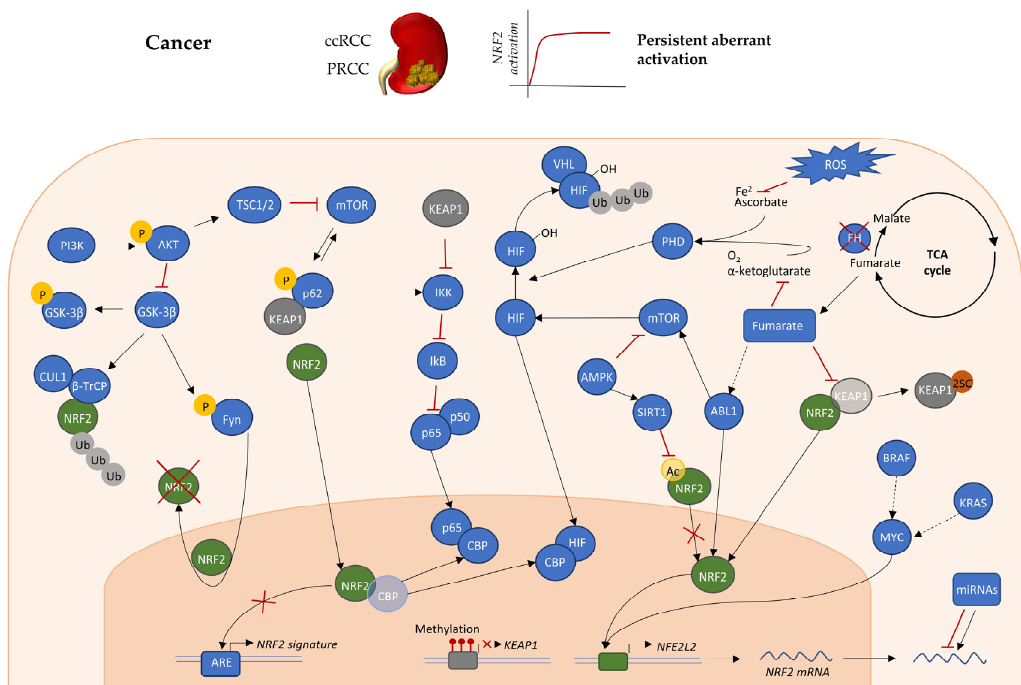
Figure 2. KEAP1-NRF2 modulation in cancers such as RCCs. The main pathways involved in KEAP1-NRF2 are epigenetic, transcriptional, and post-translational regulation in cancer. These pathways are generally mutated and deregulated in ccRCC or PRCC, thus they can account for the aberrant and persistent NRF2 activation observed in these tumor types. Dashed arrows indicate an indirect link between the two interactors of the pathway. Post-translational modifications are indicated as phosphorylation (P), ubiquitination (Ub), acetylation (Ac), and succination (2SC). Red dots on KEAP1 promoter indicate methylations.